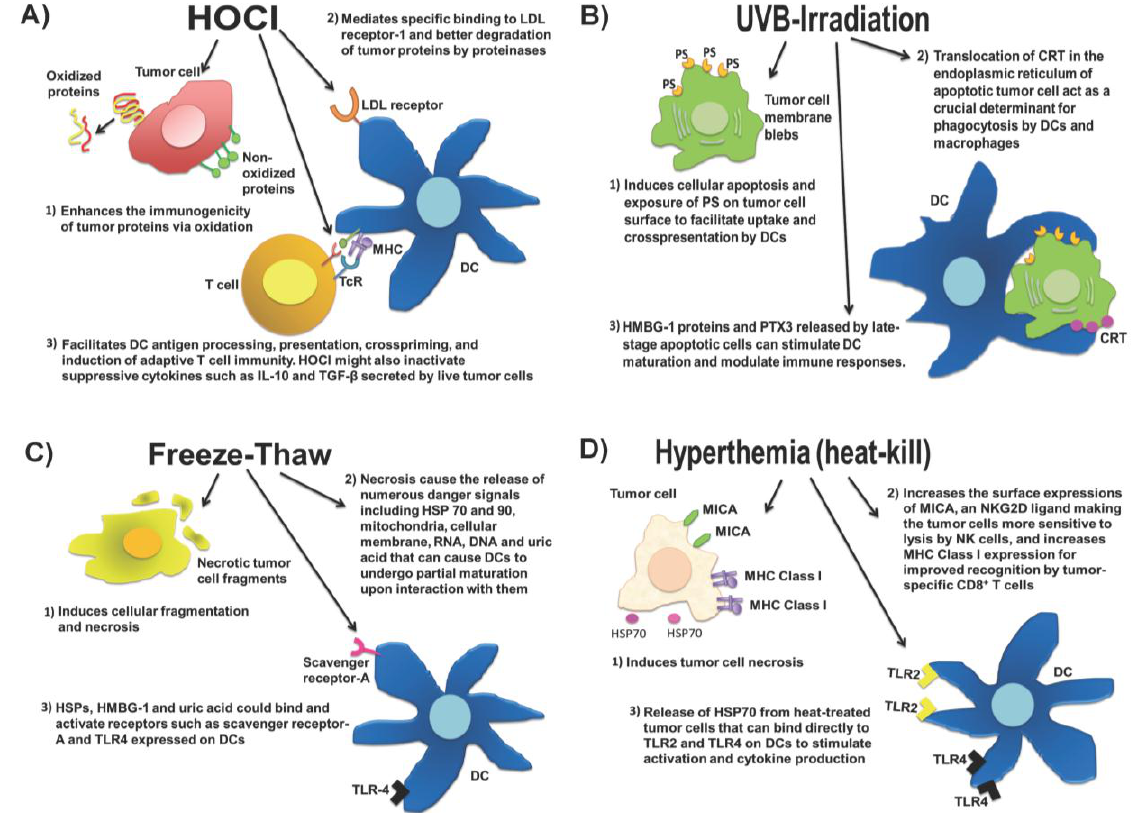
Figure 1. Four whole tumor lysate preparations currently in use in the clinics. ( A ) Hypochlorous acid (HOCl) induces rapid necrotic cell death and enhances the immunogenicity of tumor proteins via oxidation. The increased immunogenicity of HOCl-oxidized tumor proteins are due to a number of mechanisms, including specific binding of oxidized proteins to low-density lipprotein (LDL) receptor to activate dendritic cells (DCs), improved degradation of oxidized proteins by proteinases, improved DC antigen processing and presentation via the major histocompatibility (MHC) molecules, and crosspriming of tumor-specific T cells via T cell receptor (TcR). HOCl might also inactivate IL-10 and transforming growth factor (TGF)-β that can inhibit anti-tumor responses and facilitate T regulatory (Treg) cell proliferation; ( B ) Ultra-violet B (UVB)-irradiation induces apoptotic tumor cell death. This causes the exposure of phosphatidylserine (PS) and translocation of calreticulin (CRT) to facilitate DC uptake and crosspresentation of the apoptotic tumor cells. The release of high mobility box group-1 (HMGB-1) and pentraxin-3 (PTX-3) by late-stage apoptotic tumor cells can stimulate DC maturation and elicit specific anti-tumor T cell responses; ( C ) Repeated freeze-thaw treatment of tumor cells induces necrotic cell death and cause the release of numerous danger signals such as HMGB-1, heat-shock proteins (HSPs), DNA, RNA and uric acid that stimulate partial DC maturation. Danger signals such as HSPs, HMGB-1 and uric acid could bind to scavenger receptor-A and toll-like receptor (TLR) 4 on DCs to elicit immune responses; ( D ) Hyperthermia, which is heat-kill treatment of tumor cells, induces necrotic cell death and increased expression of MICA (major histocompatibility class I chain-related; natural killer group 2D [NKG2D] ligand) and MHC Class I to improved natural killer (NK) cell and antigen-specific CD8 + T cell recognition,